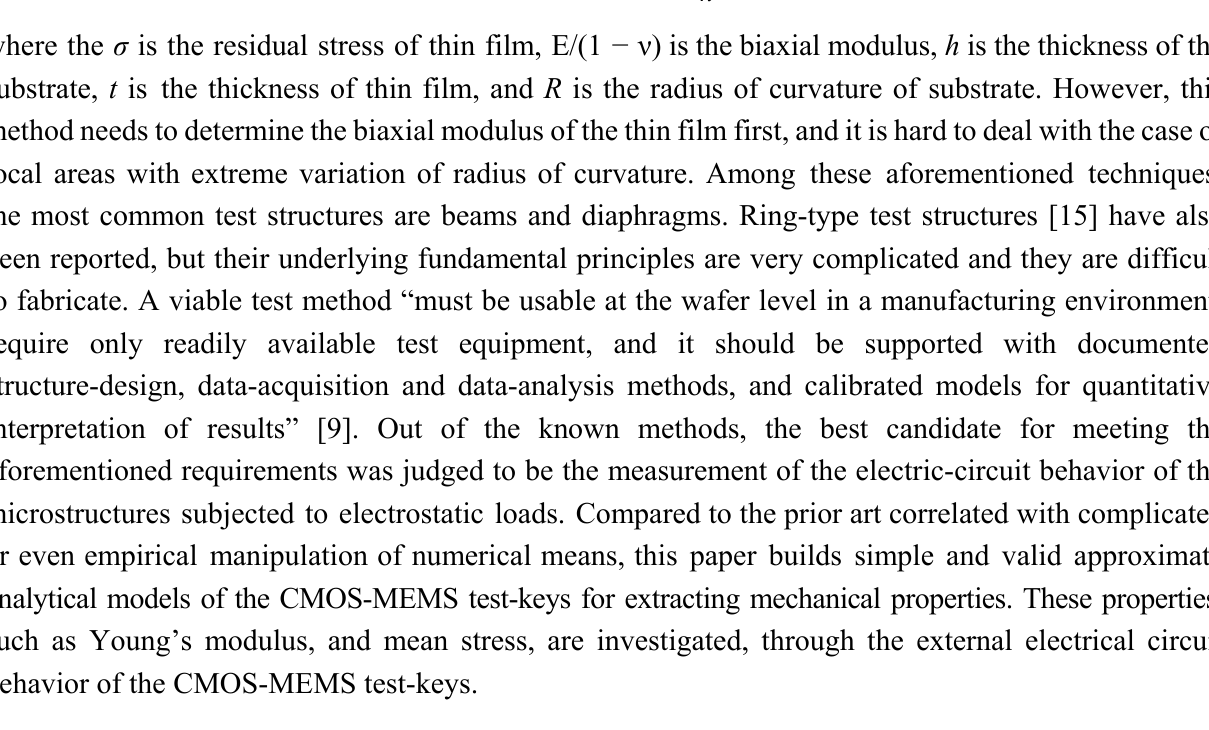
Table 1. Summary of actuation and measurement methods for extracting material properties.